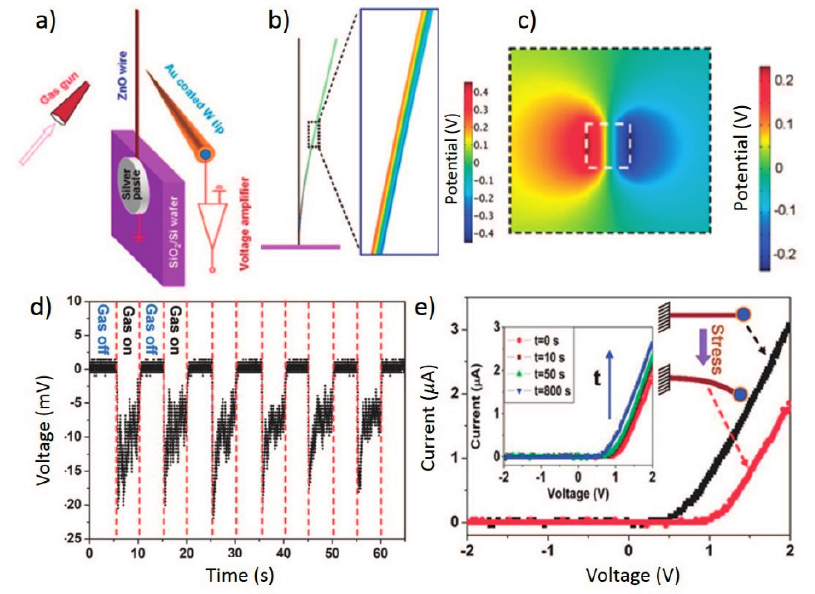
Figure 6. ( a ) Device schematic and experimental setup; FEM model of potential distribution along wire length ( b ) and cross-section ( c ); Dynamic response to gas pulses ( d ); ( e ) I-V behavior under zero and maximum deflection conditions. Recovery behavior of I-V plots inset for varying times after relaxation from maximum deflection. Adapted with permission from [67]. Copyright 2008 American Chemical